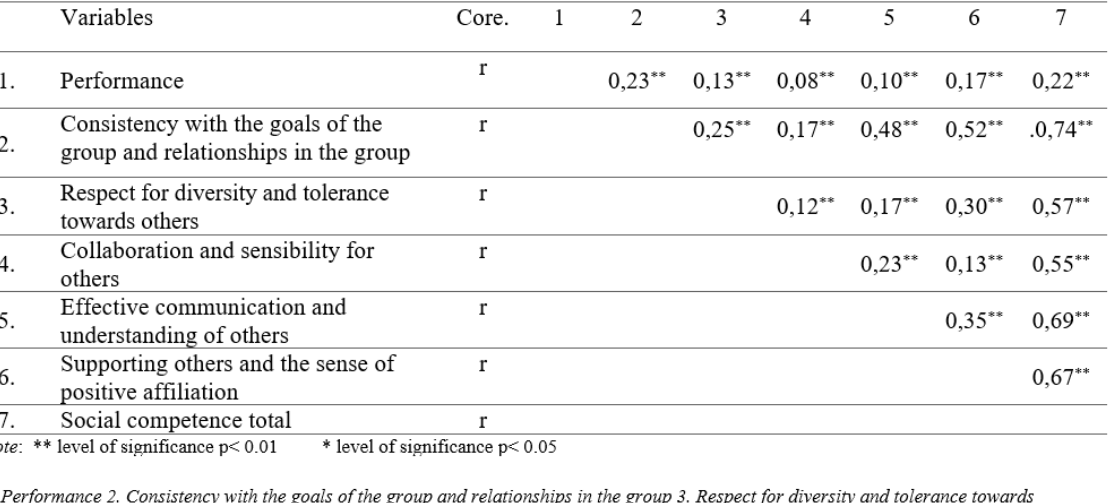
Table 8. Correlation (Pearson) between social competence and students'